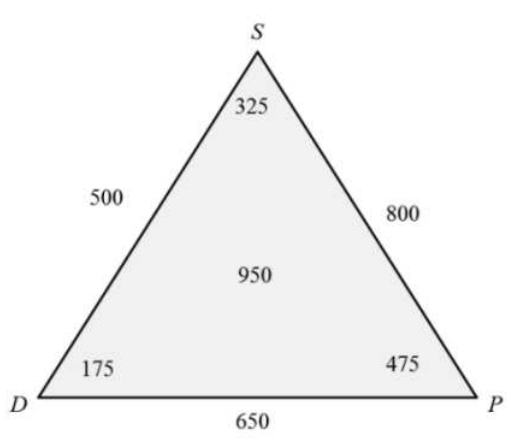
Figure 2. Offers that cannot be readily refused are the numbers in the corners of the triangle. They add up to values of each duo coalitions (at the sides of the triangle). In case of game with an empty core the sum of OCRR is greater than the grand coalition payoff